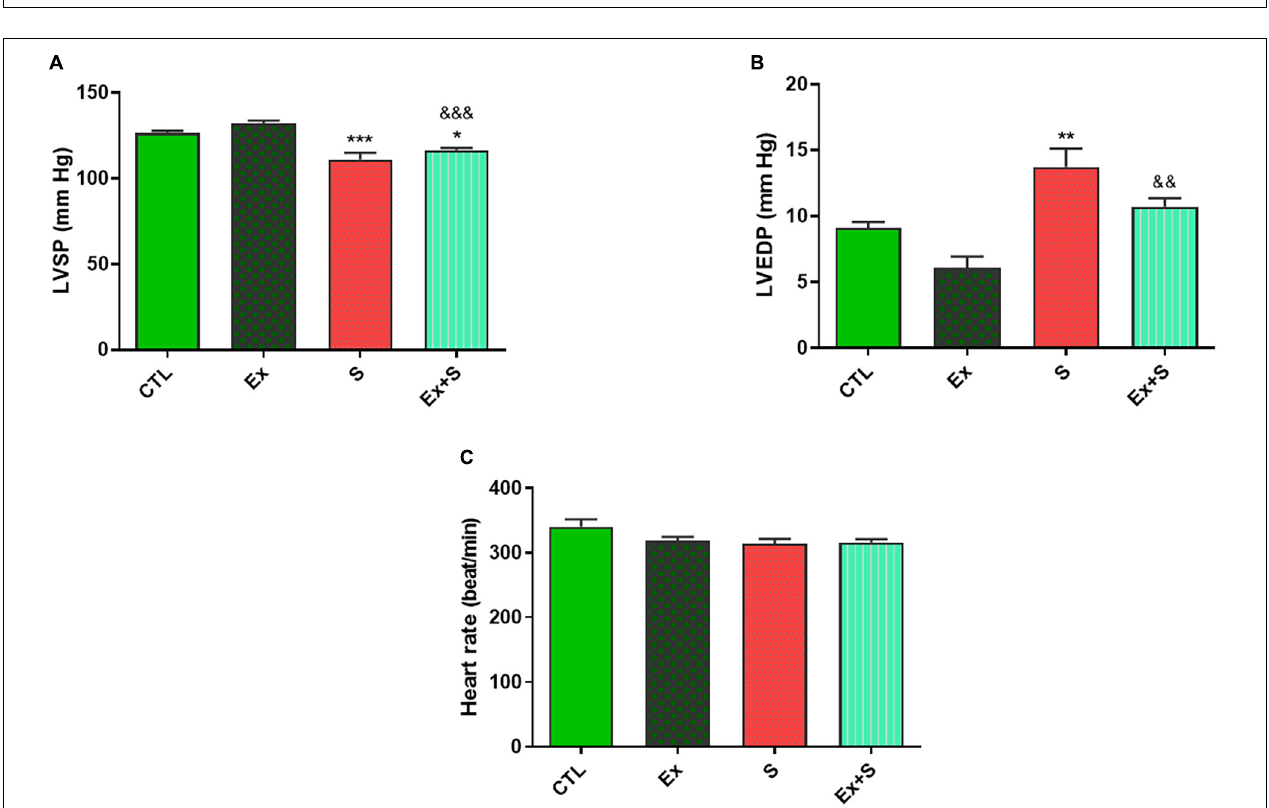
FIGURE 2 | Effects of waterpipe smoke inhalation on left ventricular systolic pressure (LVSP) (A) , left ventricular end diastolic pressure (LVEDP) (B) , and heart rate (C) in experimental groups. CTL, control group; Ex, group subjected to exercise training for 8 weeks; S, group subjected to waterpipe tobacco smoke inhalation for 8 weeks; Ex + S, group subjected to exercise training and waterpipe tobacco smoke inhalation for 8 weeks. The results are presented as mean ± SEM, n = 7. * P < 0.05; ** P < 0.01; *** P < 0.001 vs. CTL; && P < 0.01, &&& P < 0.001 vs.